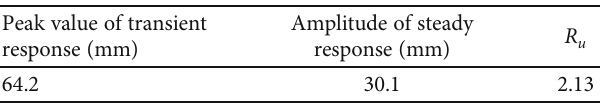
Figure 4: Response of low-pressure compressor disk of low-pressure rotor system. Table 2: Response value of a low-pressure compressor disk of a low-pressure rotor